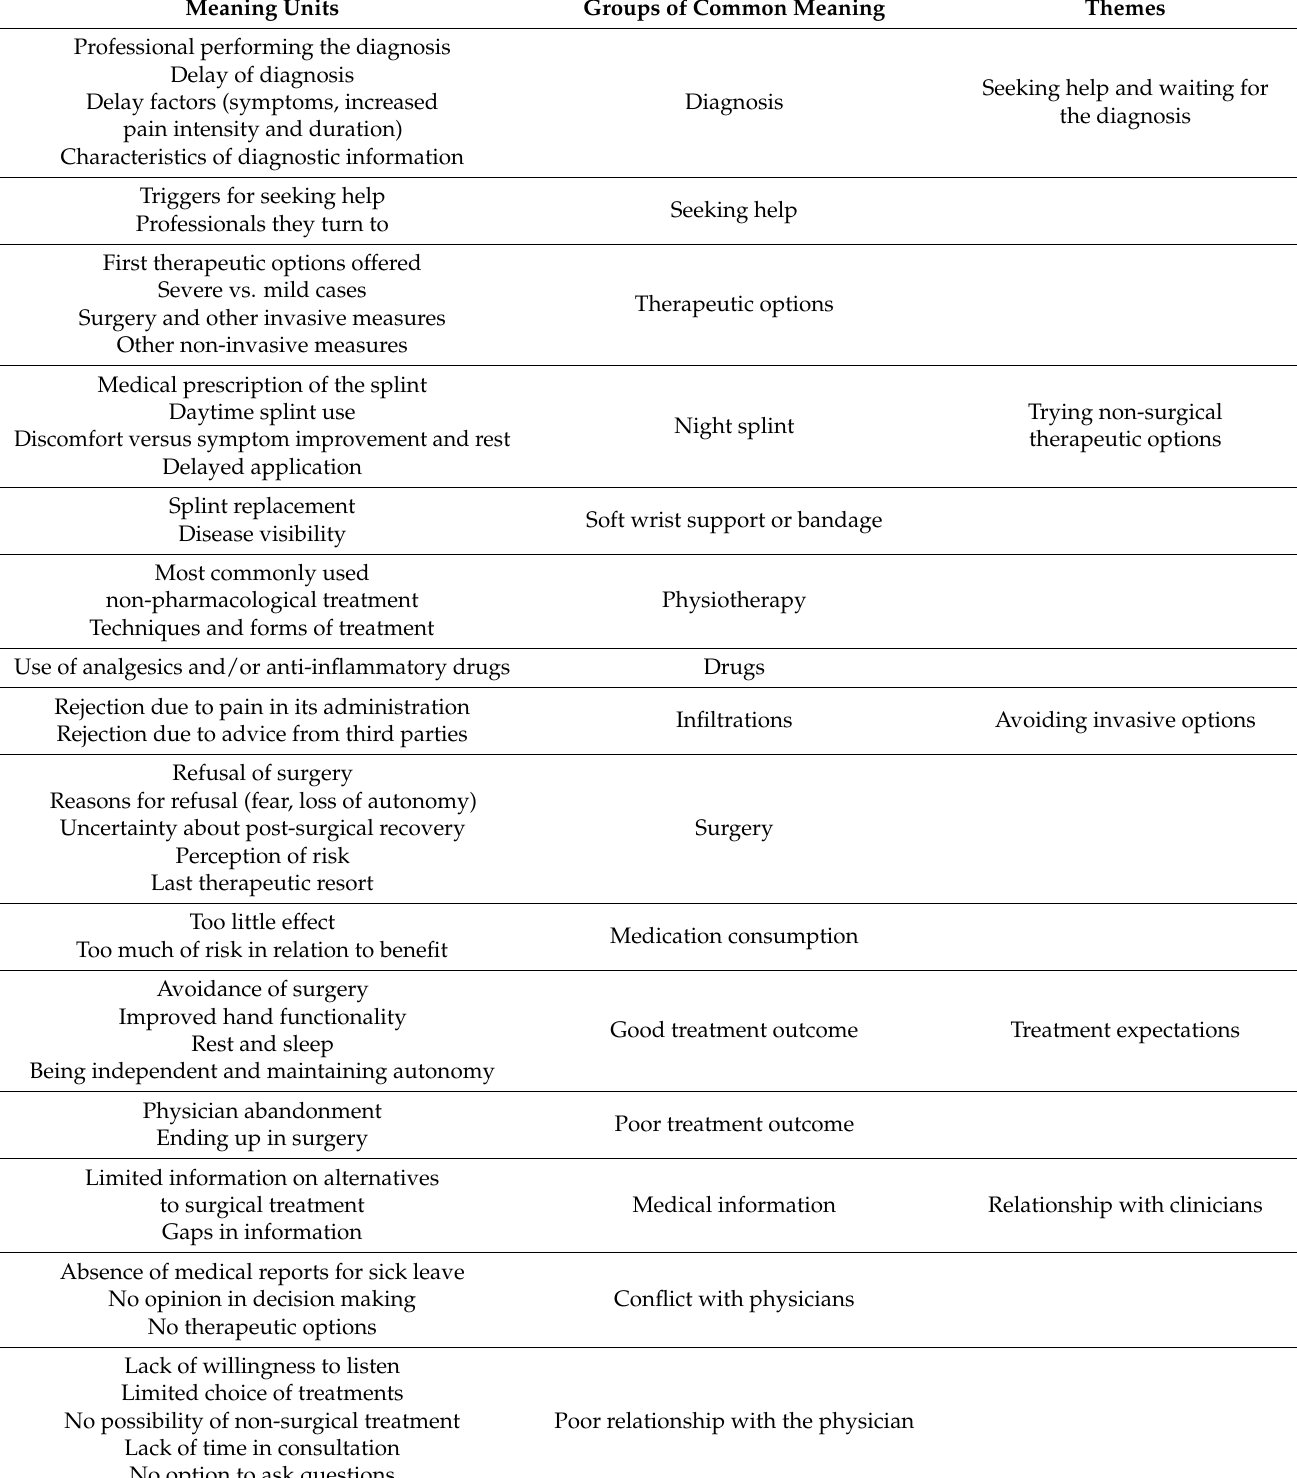
Table 4. Summary of the coding